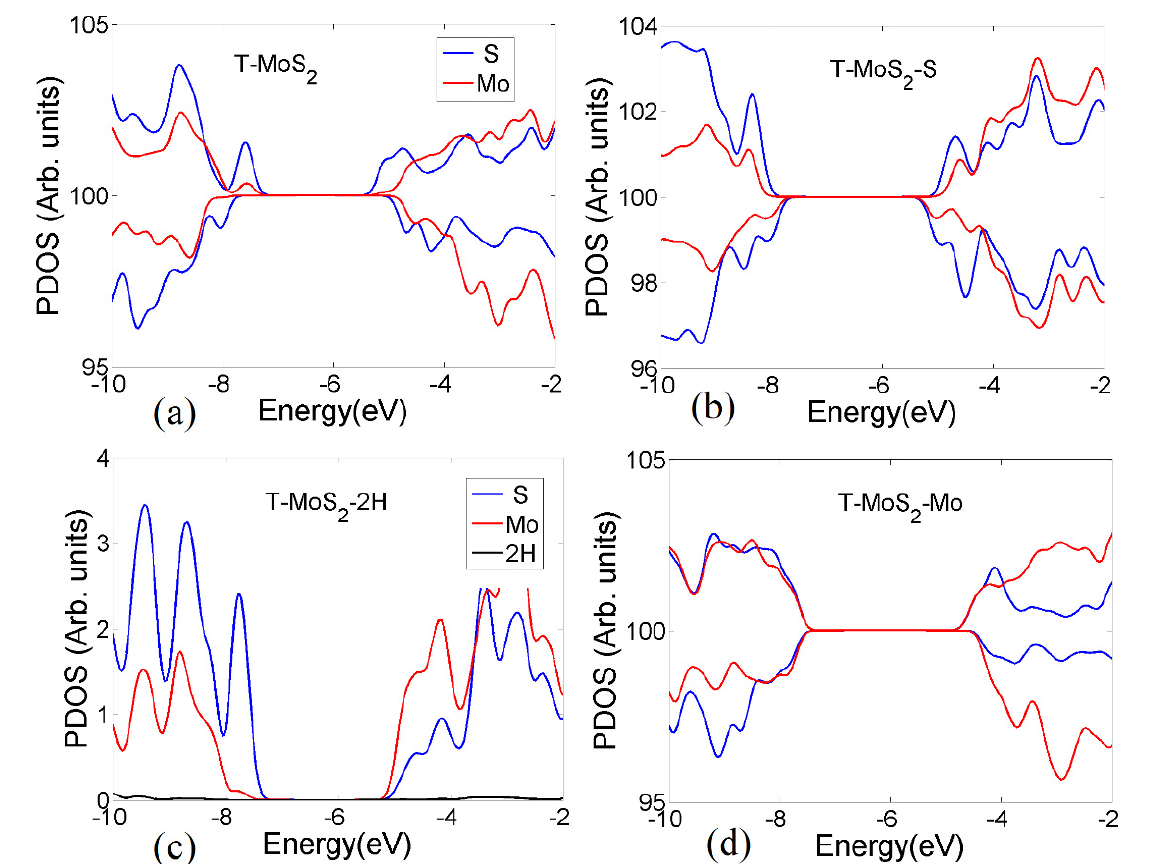
Figure 4. Electronic density of states of T ‐ MoS 2 before ( a , d ) and after ( b , c ) edge passivation with S and 2H.